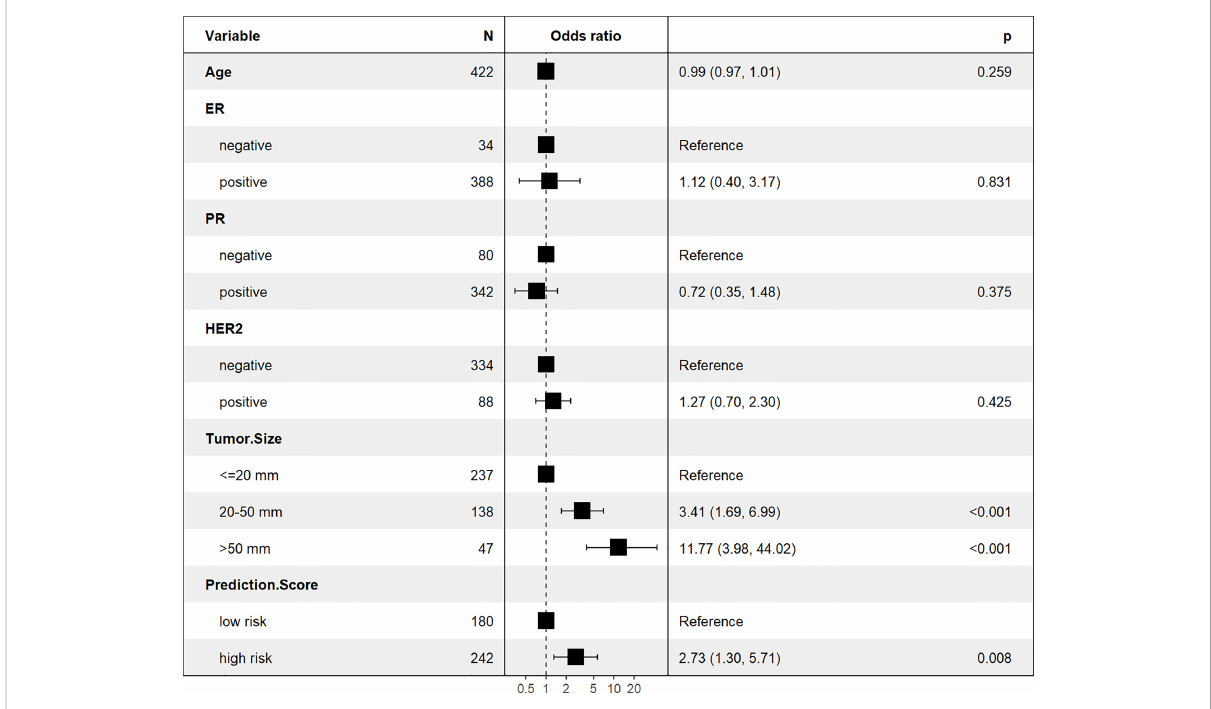
FIGURE 7 The multivariable logistic regression analysis for LNM prediction.